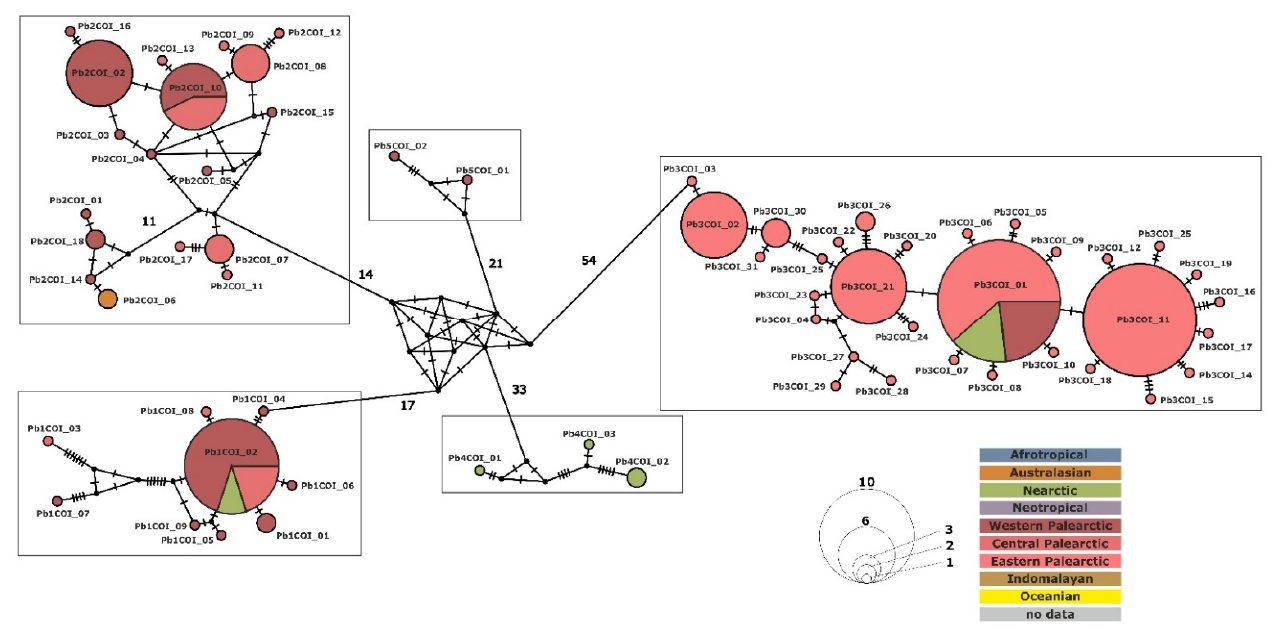
Figure 4. Haplotype network of the Paramecium bursaria complex constructed using 132 mitochondrial COI gene sequences. The network presents the origin and interrelationships among P. bursaria strains. Hatch marks on particular branches represent nucleotide substitutions (the corresponding number is provided for more than 10 substitutions). Analyses are conducted using the median joining method in PopART software v. 1.7.